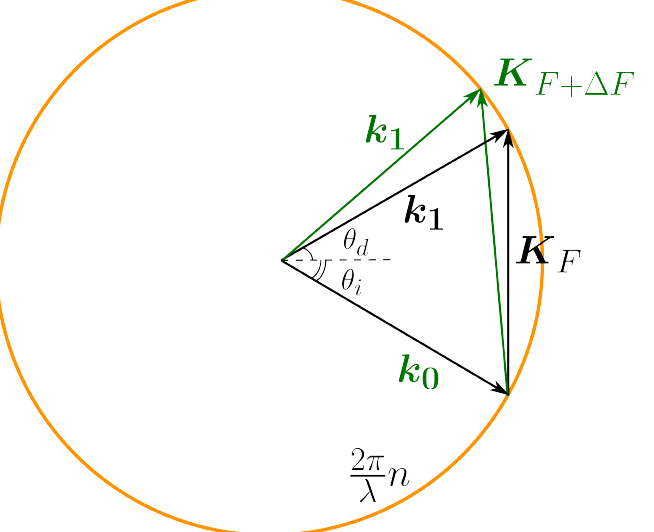
Figure 1. Wave vector diagram of AO diffraction on ultrasound with frequency F (black) and F + ∆ F